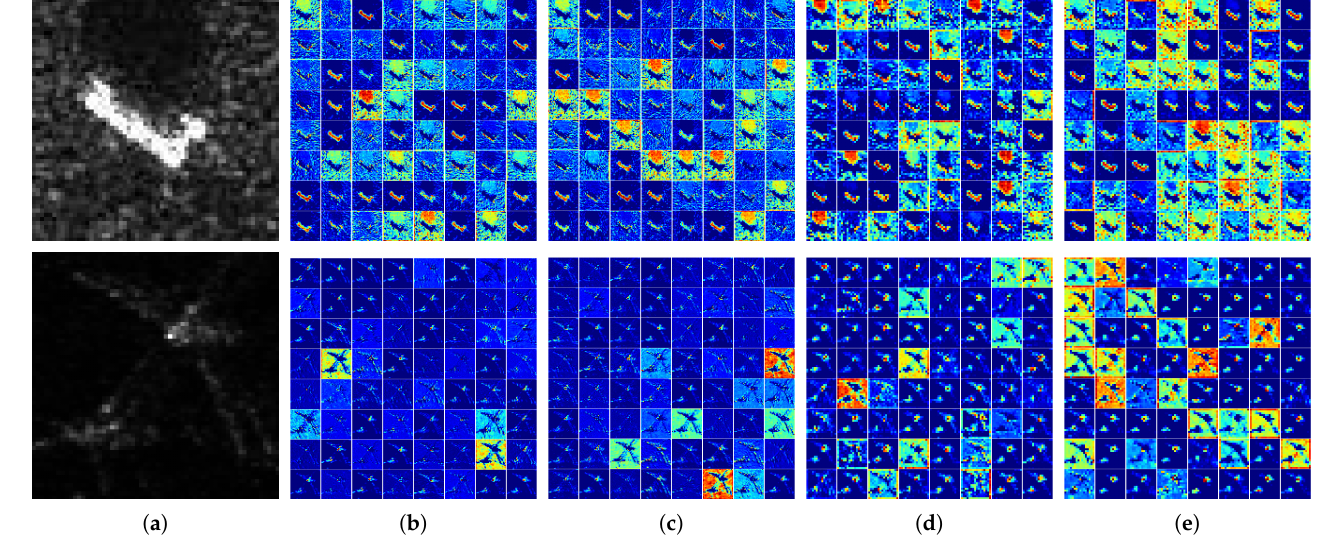
Figure 10. Feature map comparison between baseline and our proposed model, illustrating: ( a ) the input image, ( b ) the feature maps from the first convolutional layer of our proposed model, ( c ) the feature maps from the first convolutional layer of the baseline model, ( d ) the feature maps from the second convolutional layer of our proposed model, ( e ) the feature maps from the first convolutional layer of the baseline